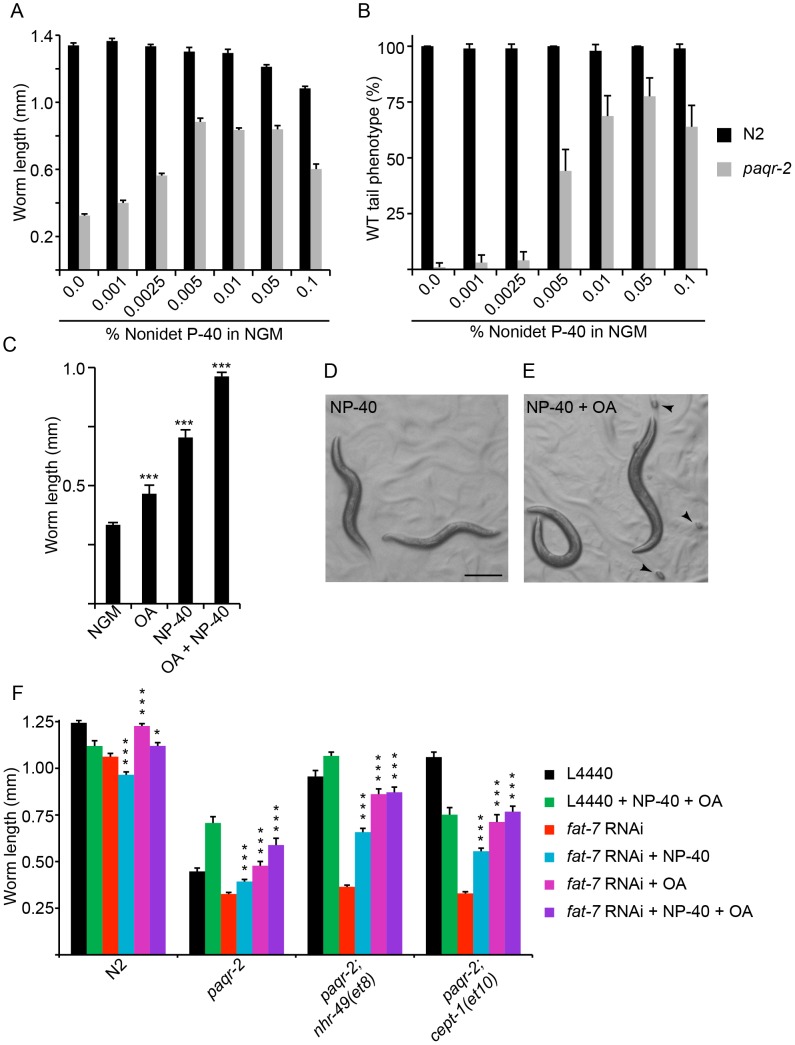
Detergents and oleic acid can suppress the paqr-2 mutant phenotypes.Low concentrations of Nonidet P-40 (NP-40; A–B) suppress the paqr-2 growth defect at 15°C and the tail tip defect at 20°C. (C) 1 mM oleic acid (OA) slightly improves growth of paqr-2 mutants at 15°C, but not as well as 0.1% Nonidet P-40 (NP-40) or the combination of both. paqr-2 mutants treated with 0.1% NP-40 alone grow into sterile adults (D), and adding also 1 mM oleic acid (OA) restores fertility (E; arrowheads indicate eggs). (F) RNAi against fat-7 inhibits the paqr-2 suppression by nhr-49(et8) and cept-(et10) but even these double mutants can grow at 15°C when NP-40 or OA are provided exogenously either alone or in combination. Scale bar in D represents 250 µm. *:p<0.05; ***: p<0.001.